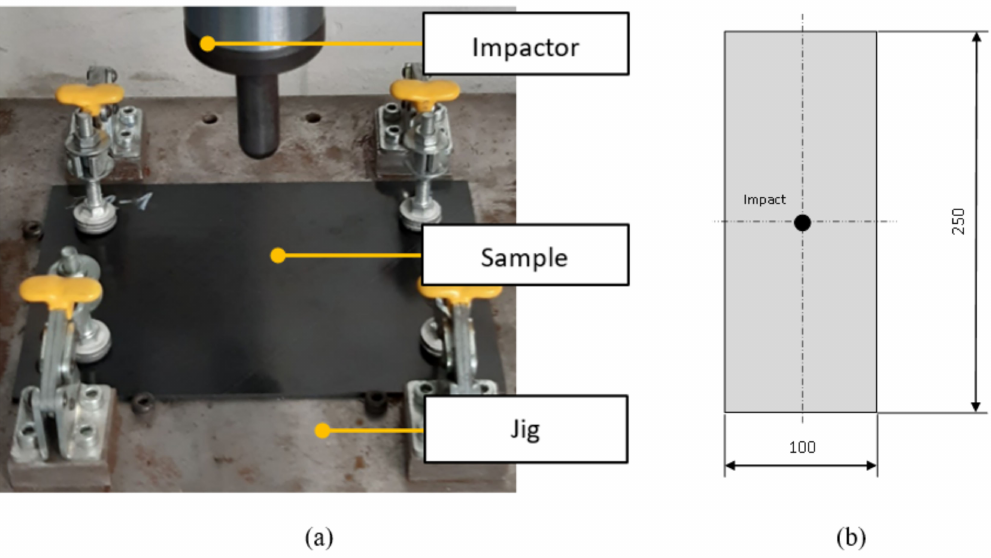
Figure 4. Impact on the specimen; Experiment ( a ); Impact sample ( b